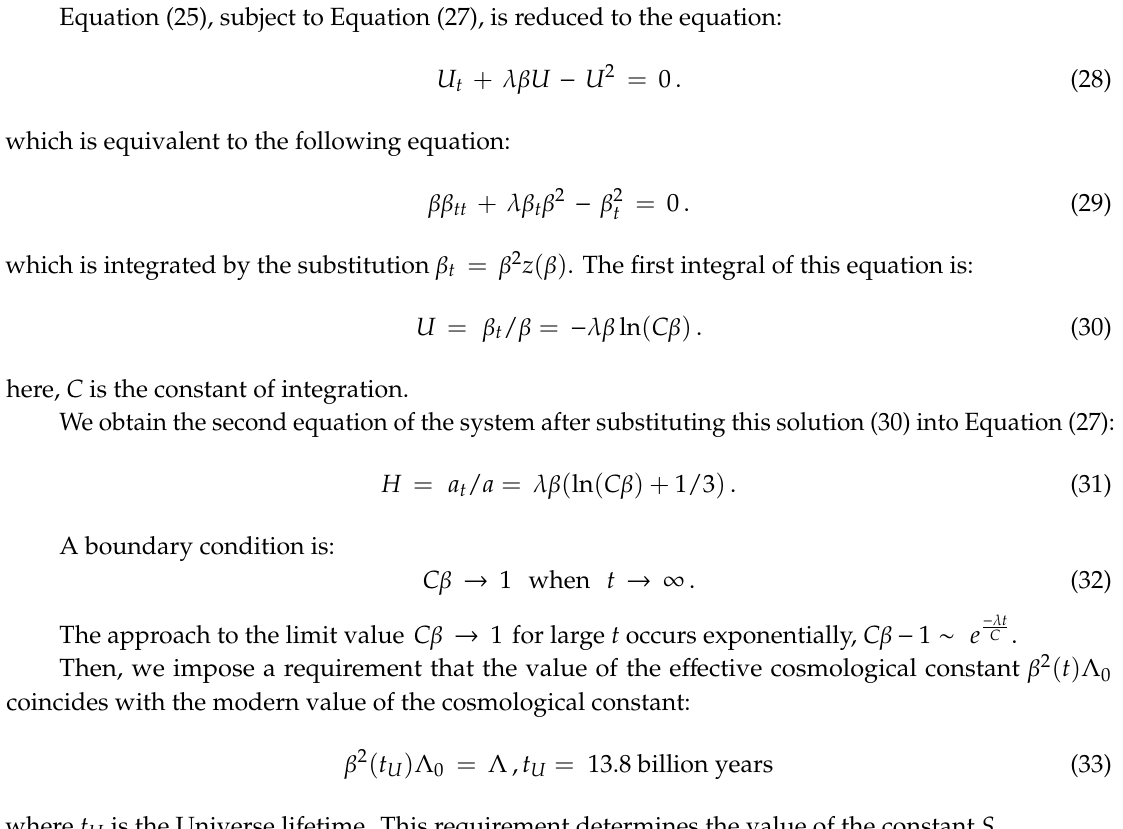
Figure 2. Model of behavior of the functions ( ) a t and ( ) С